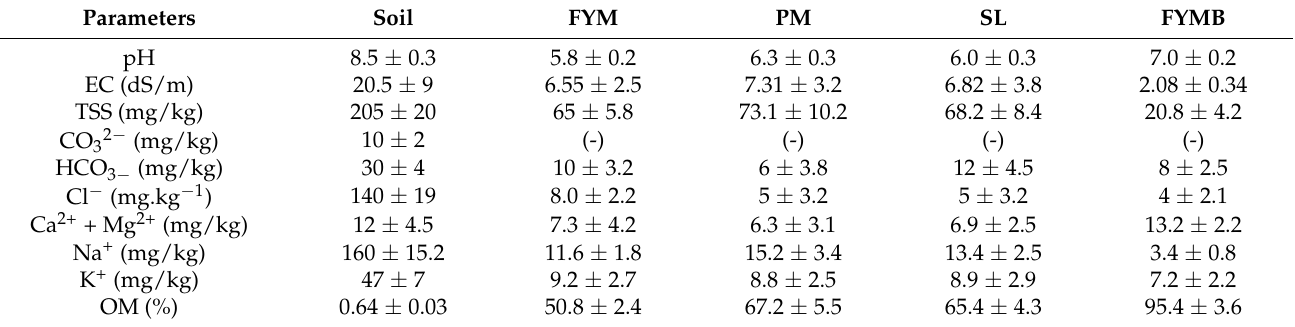
Table 3. Analysis of selected parameters for soil and other organic amendments used in the experiment.